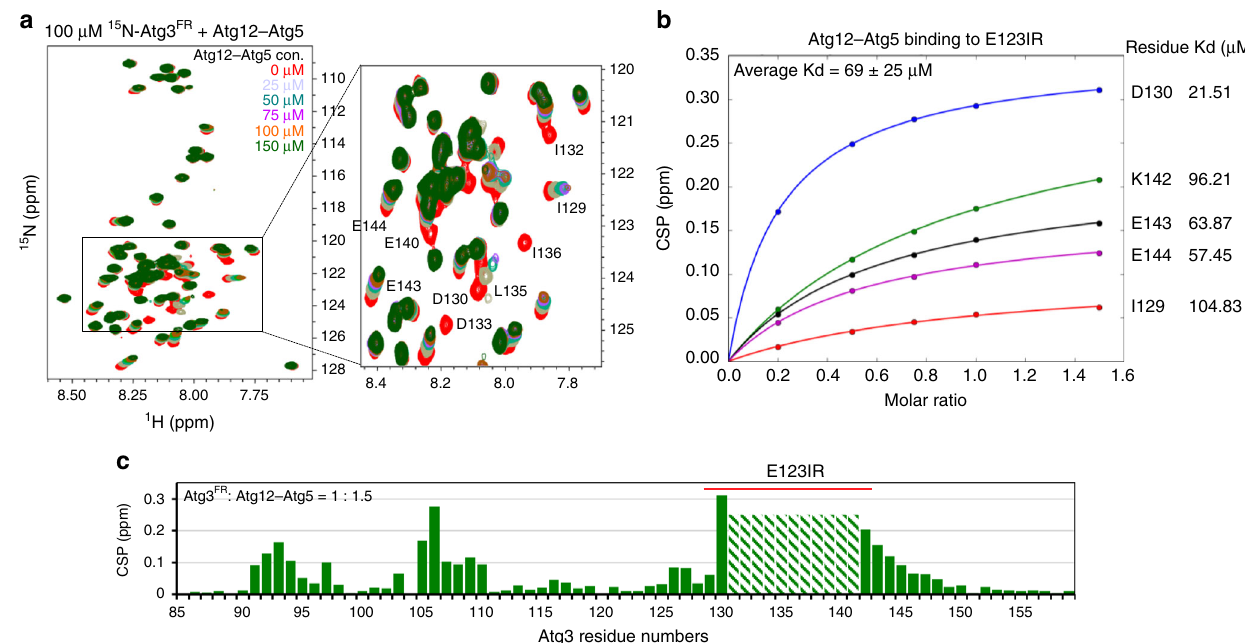
Fig. 3 E123IR interacts with autophagy E3. a [ 15 N, 1 H] TROSY spectra of 15 N-labeled Atg3 FR titrated with unlabeled Atg12 – Atg5-Atg16. b Estimated binding af fi nities between E123IR residues and Atg12 – Atg5, based on chemical shift perturbations (CSPs) observed upon titrating increasing concentrations of Atg12 – Atg5. c Chemical shift perturbations plotted as a function of Atg3 FR residue numbers, with resonances showing intermediate exchange line broadening indicated by